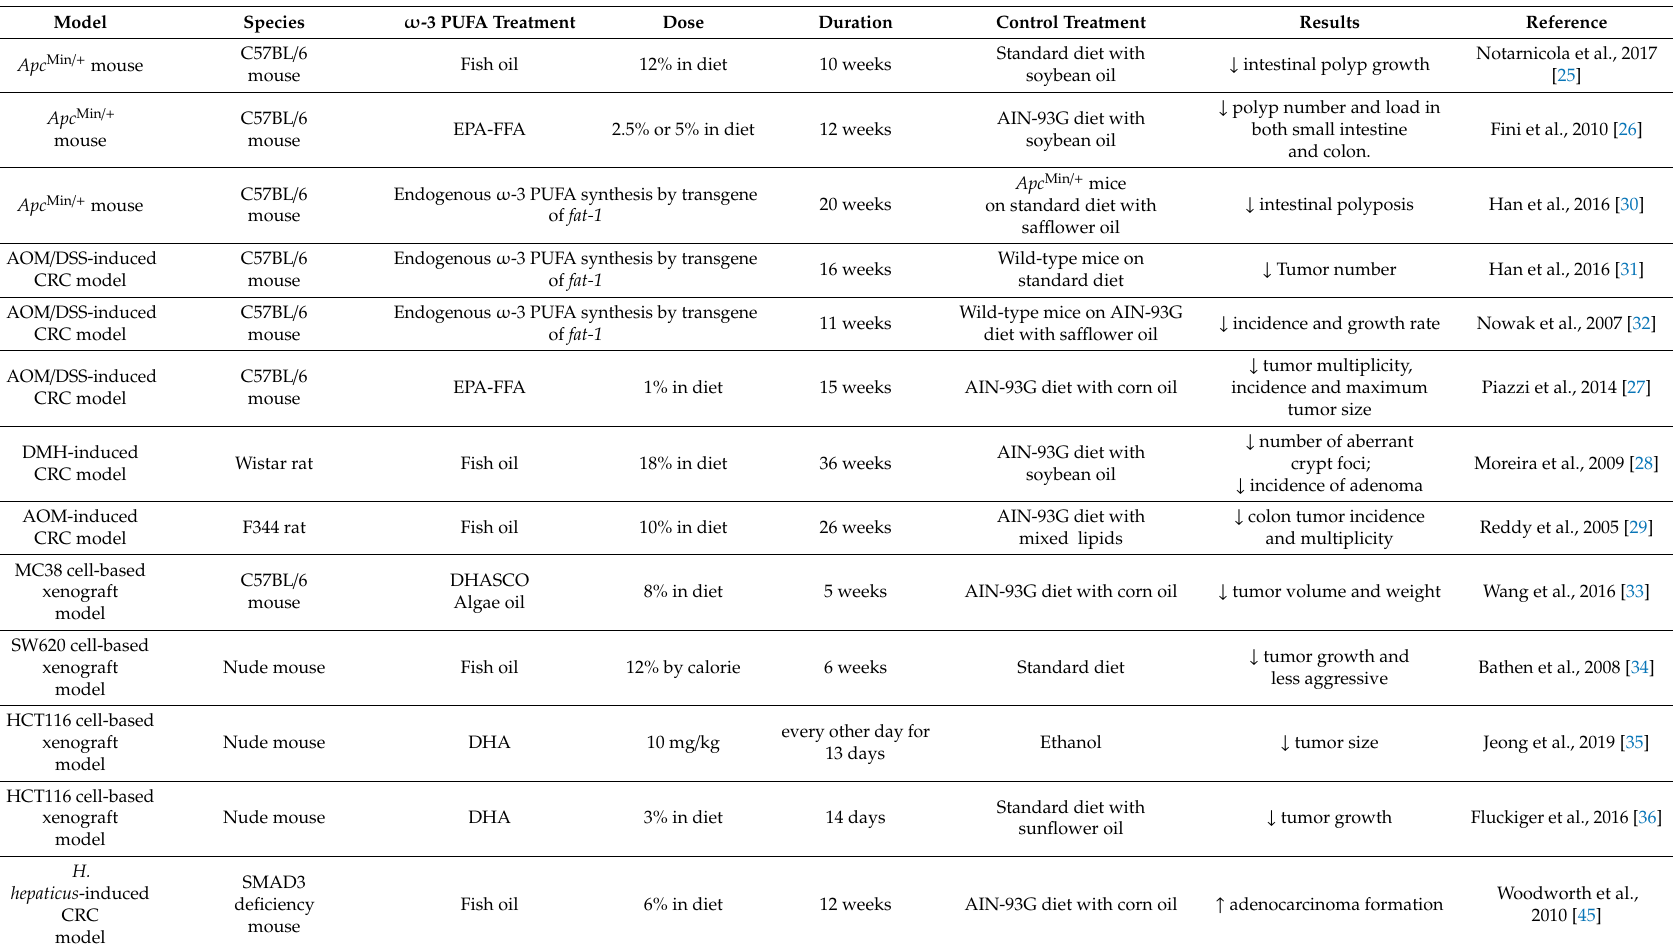
Table 2. Preclinical studies of ω -3 PUFA supplementation for the prevention / treatment of